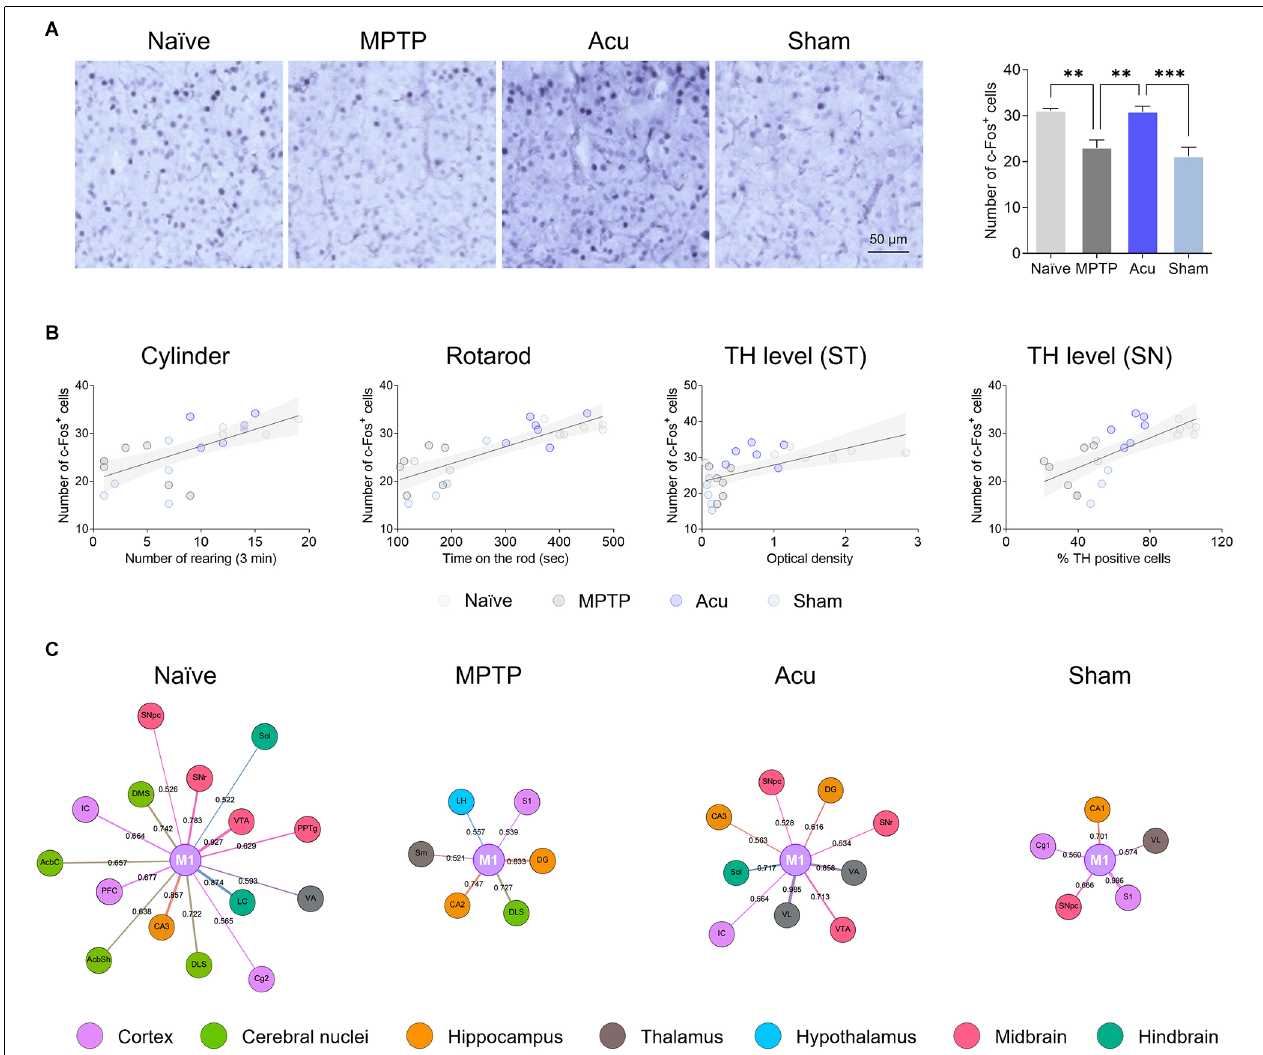
FIGURE 5 | Network generation centered in M1. (A) The decreased c-Fos-positive cells in the M1 region of the MPTP-induced PD model were restored by acupuncture treatment. n = 6/group, ∗∗∗ p < 0.001, ∗∗ p < 0.01. Data is mean ± SEM following the one-way ANOVA followed by the Tukey’s test. (B) Correlation of c-Fos expression level in the M1 between cylinder, rotarod, TH level in the ST or SN: Cylinder, r 2 = 0.5096, p < 0.001; Rotarod, r 2 = 0.4889, p < 0.001; TH level (ST), r 2 = 0.3021, p = 0.005; TH level (SN), r 2 = 0.3918, p = 0.001. (C) Network analysis centered on M1. Node size is determined by betweenness. Edge betweenness determines the thickness and color intensity of the